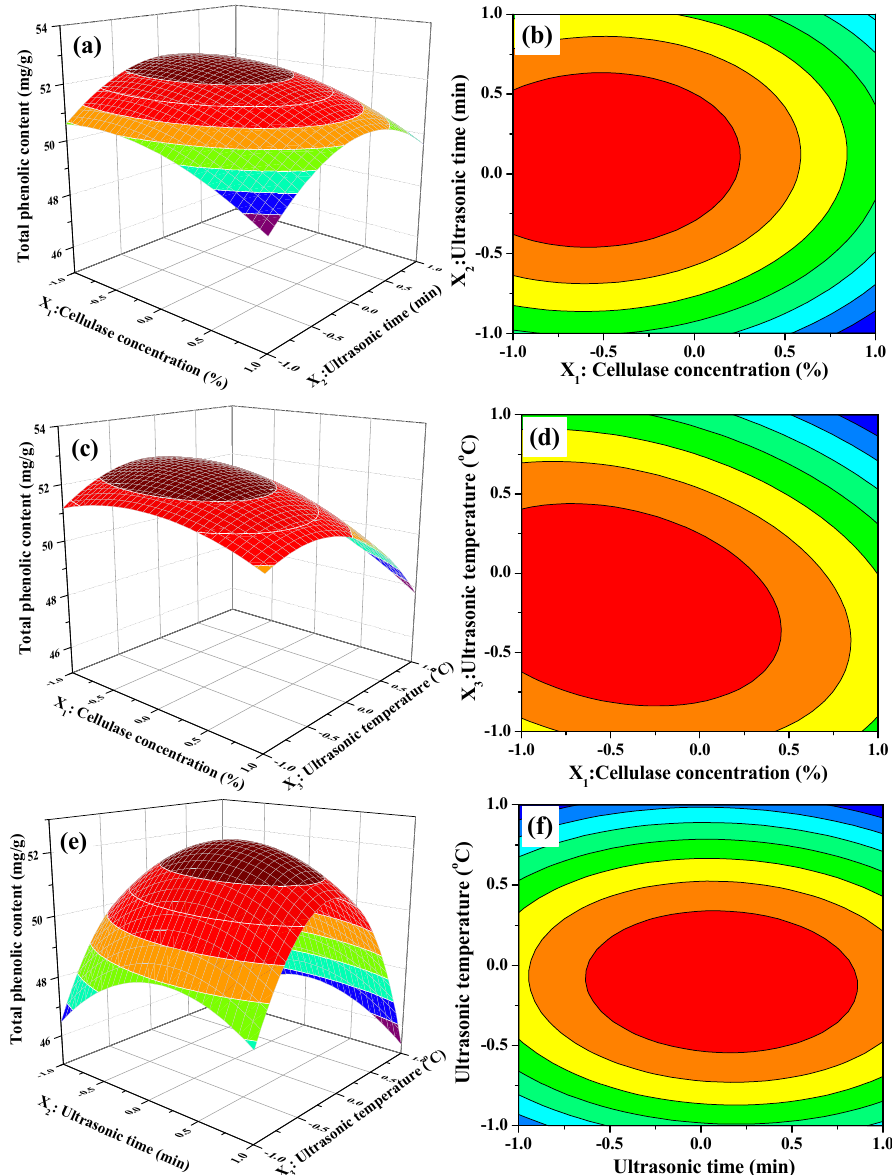
Figure 2. Contour ( a , c , e ); and response surface ( b , d , f ) plots for interactions between three independent extraction parameters on the extraction yields of phenolic extracts ( X 1 : Cellulase Concentration; X 2 : Ultrasonic Time; and X 3 : Ultrasonic Temperature).